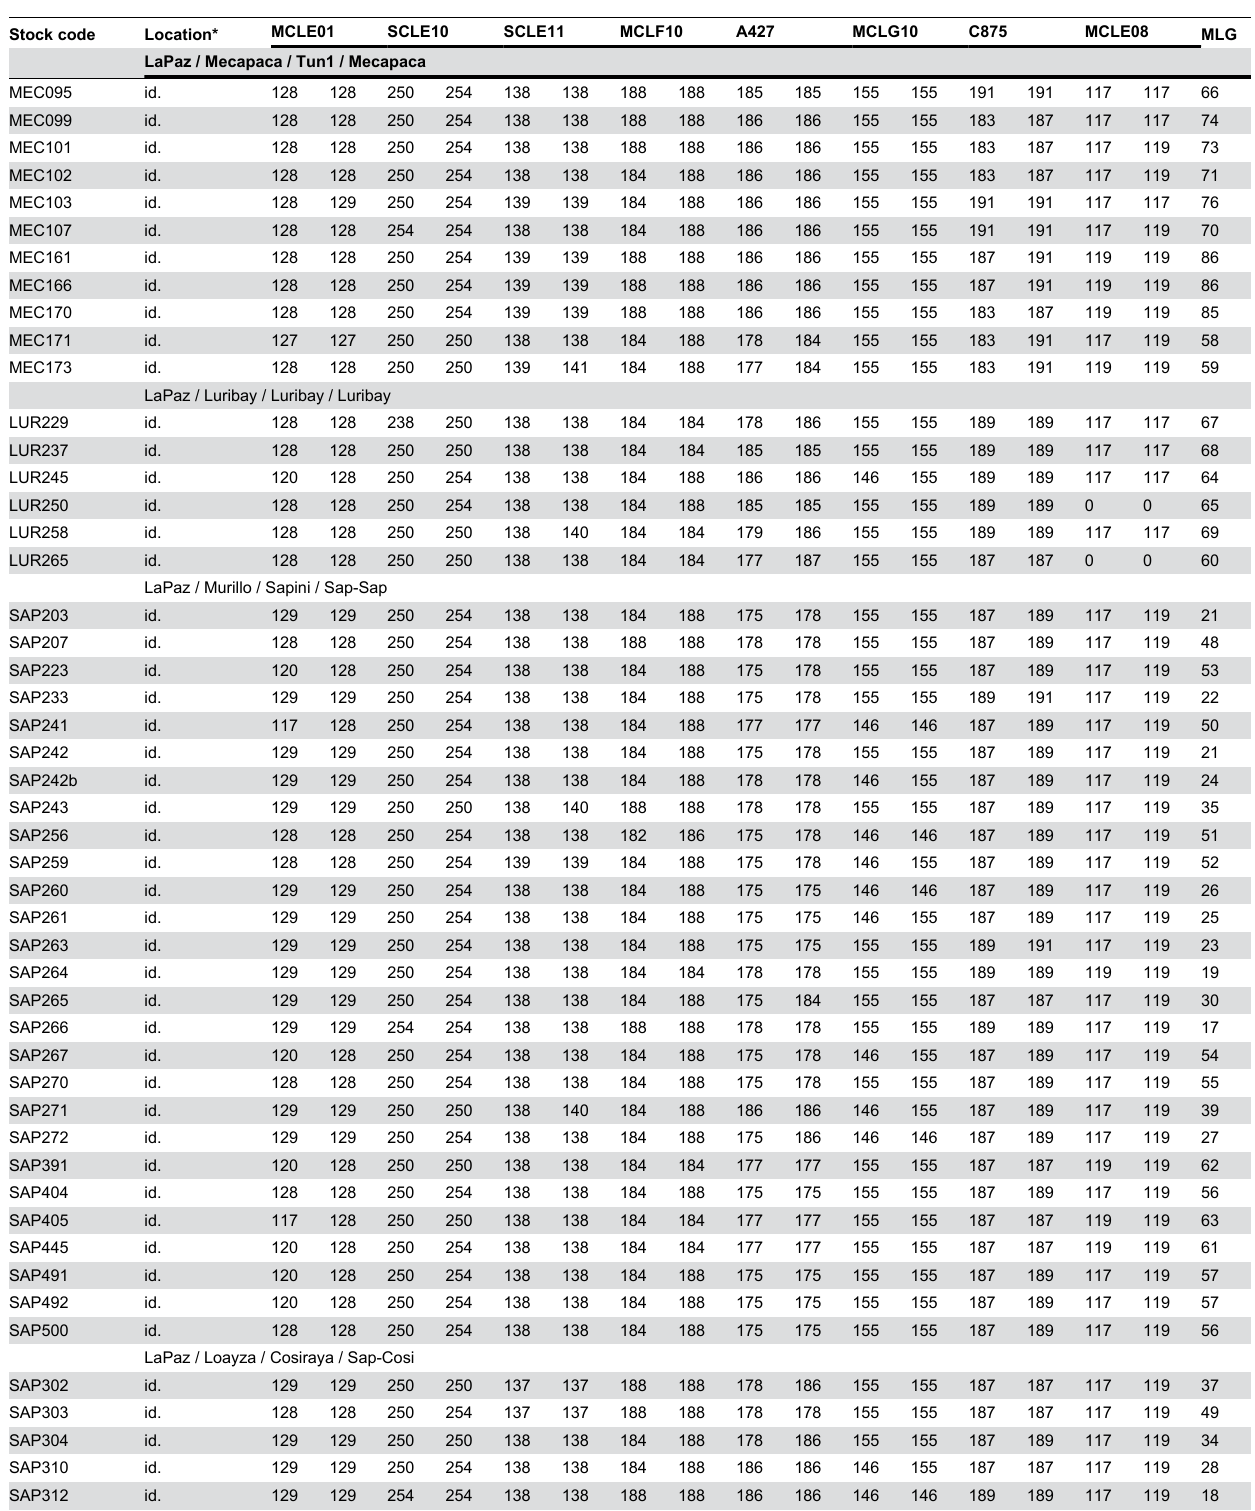
Table 1. Codes, locations, genotypes at each locus and reference numbers of each multilocus genotype (MLG) of the